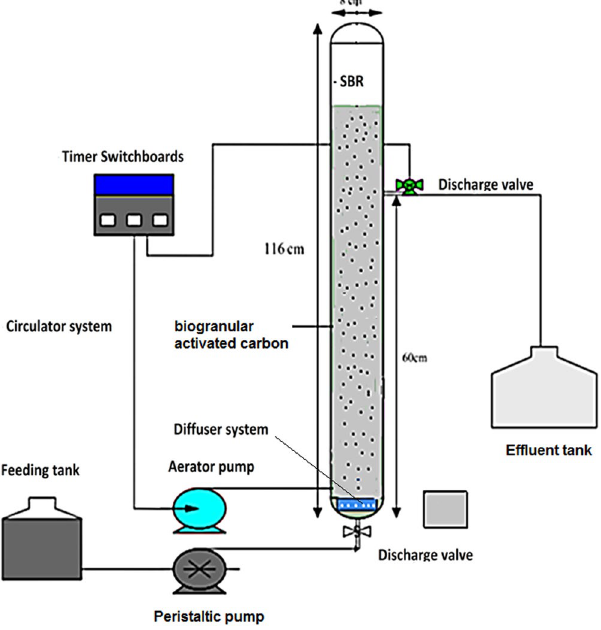
Figure 1. Schematic diagram of integrated anaerobic-aerobic/biogranular activated carbon sequencing batch reactor